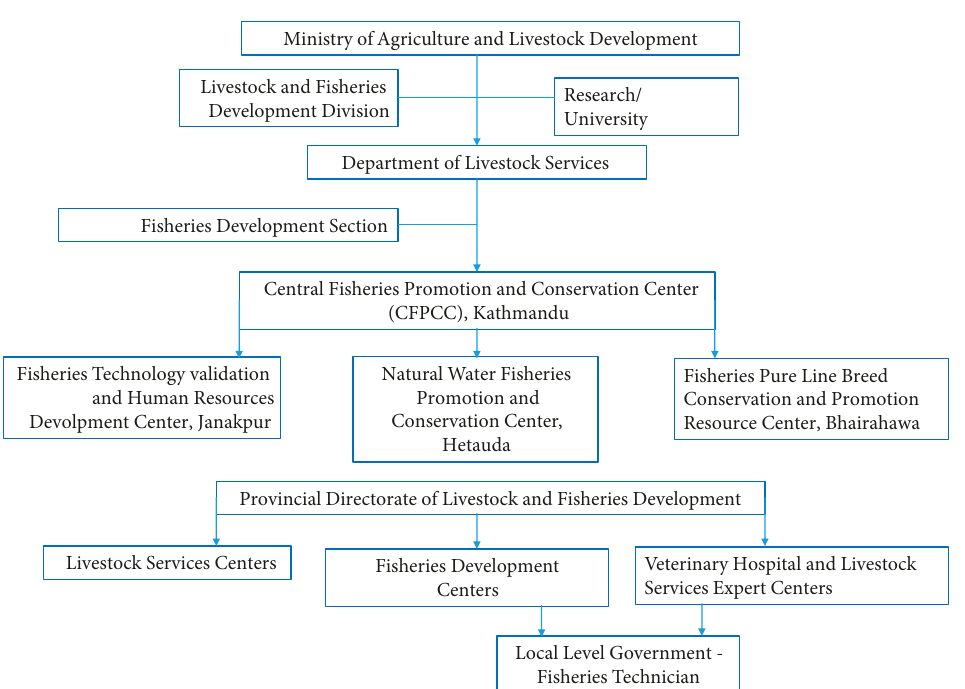
Figure 7: Institutional framework for aquaculture and fisheries development in Nepal, source: [48,